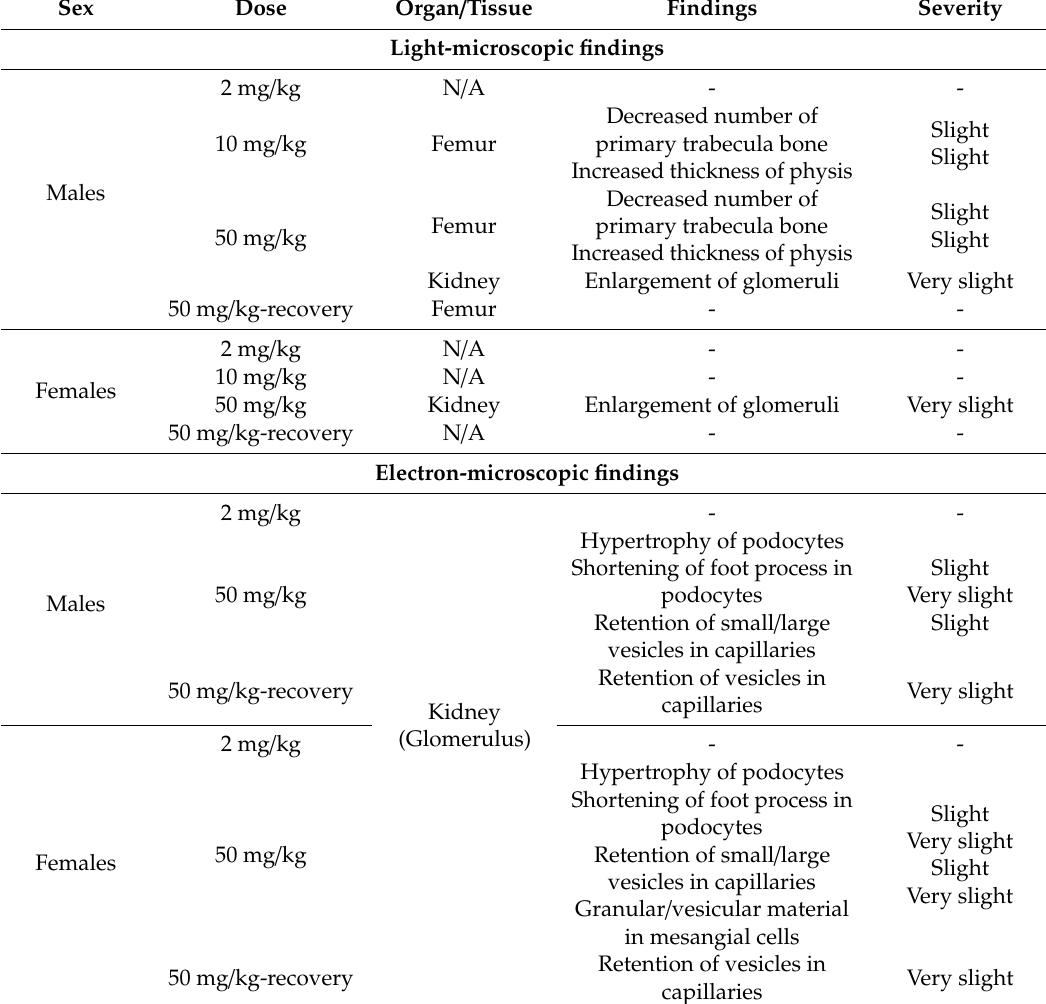
Table 4. A summary of histopathological findings in cynomolgus monkeys that received